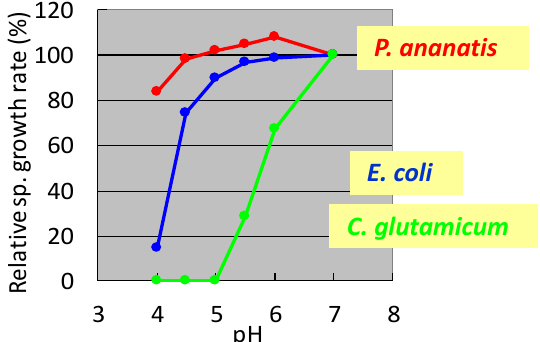
Figure 1. Effect of pH on the specific growth rate of Corynebacterium glutamicum , Escherichia coli , and Pantoea ananatis . The growth rate of each strain at pH 7 was 100%. C. glutamicum : green, E. coli ; blue, P. ananatis : red. The data are typical results from three or more independent experiments.